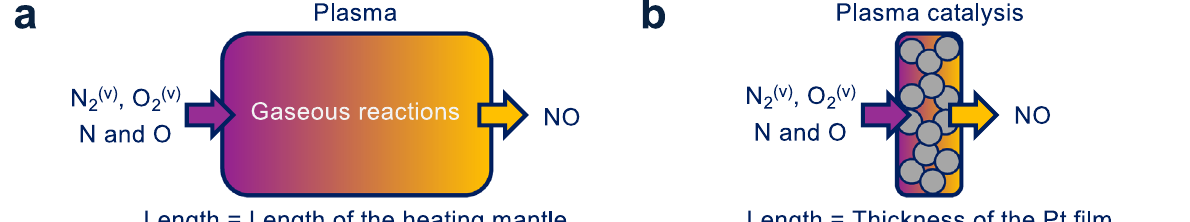
Fig. 1d. We next look to understand the observed sensitivity to O 2